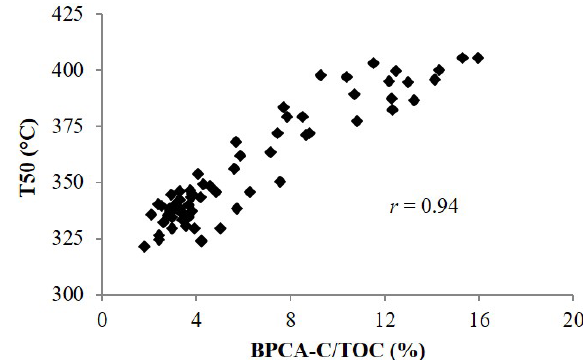
Figure 6. Temperature of 50% heat release of bulk soils from Ger- many against the fraction of C from BPCA (denoted as BPCA- C/TOC in the